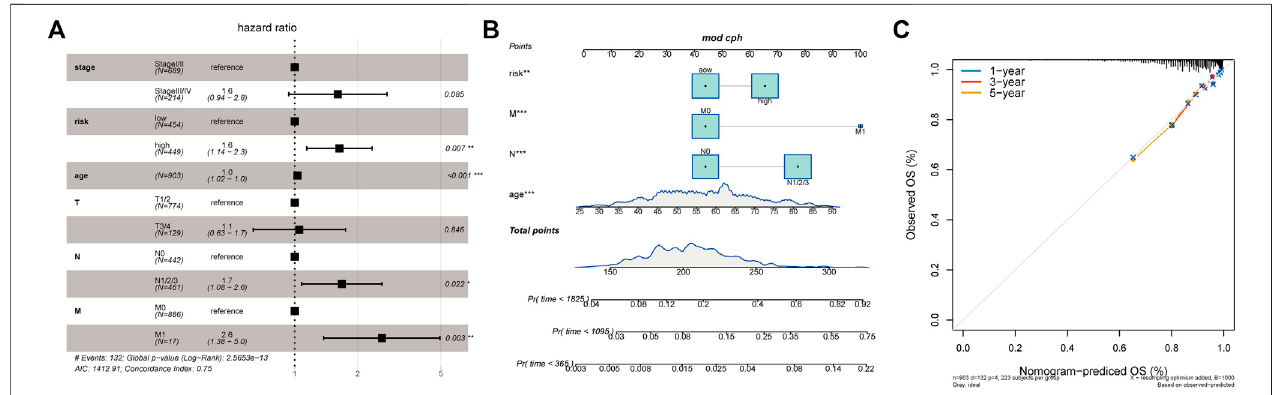
FIGURE 8 | Relationship between tumor risk score and clinical characteristics. (A) : Multivariate Cox analysis of clinical characteristics and risk score; (B) : The nomogram of clinical characteristics and risk score; (C) : The validation plots of 1-, 3-, and 5-year nomogram.